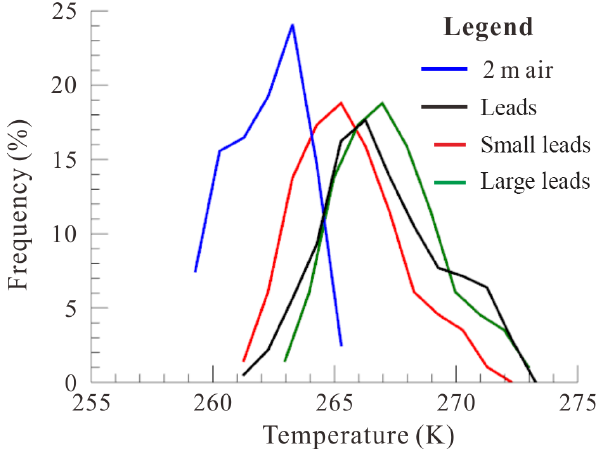
Figure 12. Distribution of 2m air temperature over leads and sur- face temperature of all leads, small leads with width < 1km, and larger leads with width >